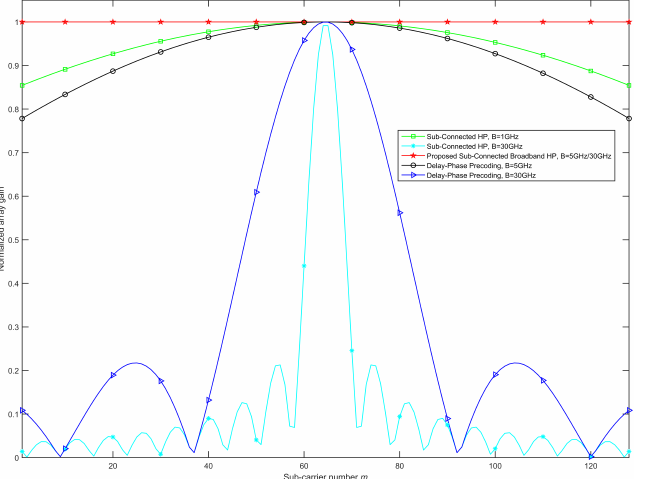
Figure 4. Normalized array gain of each subcarrier at different bandwidth-frequency ratios in beam aggregation.